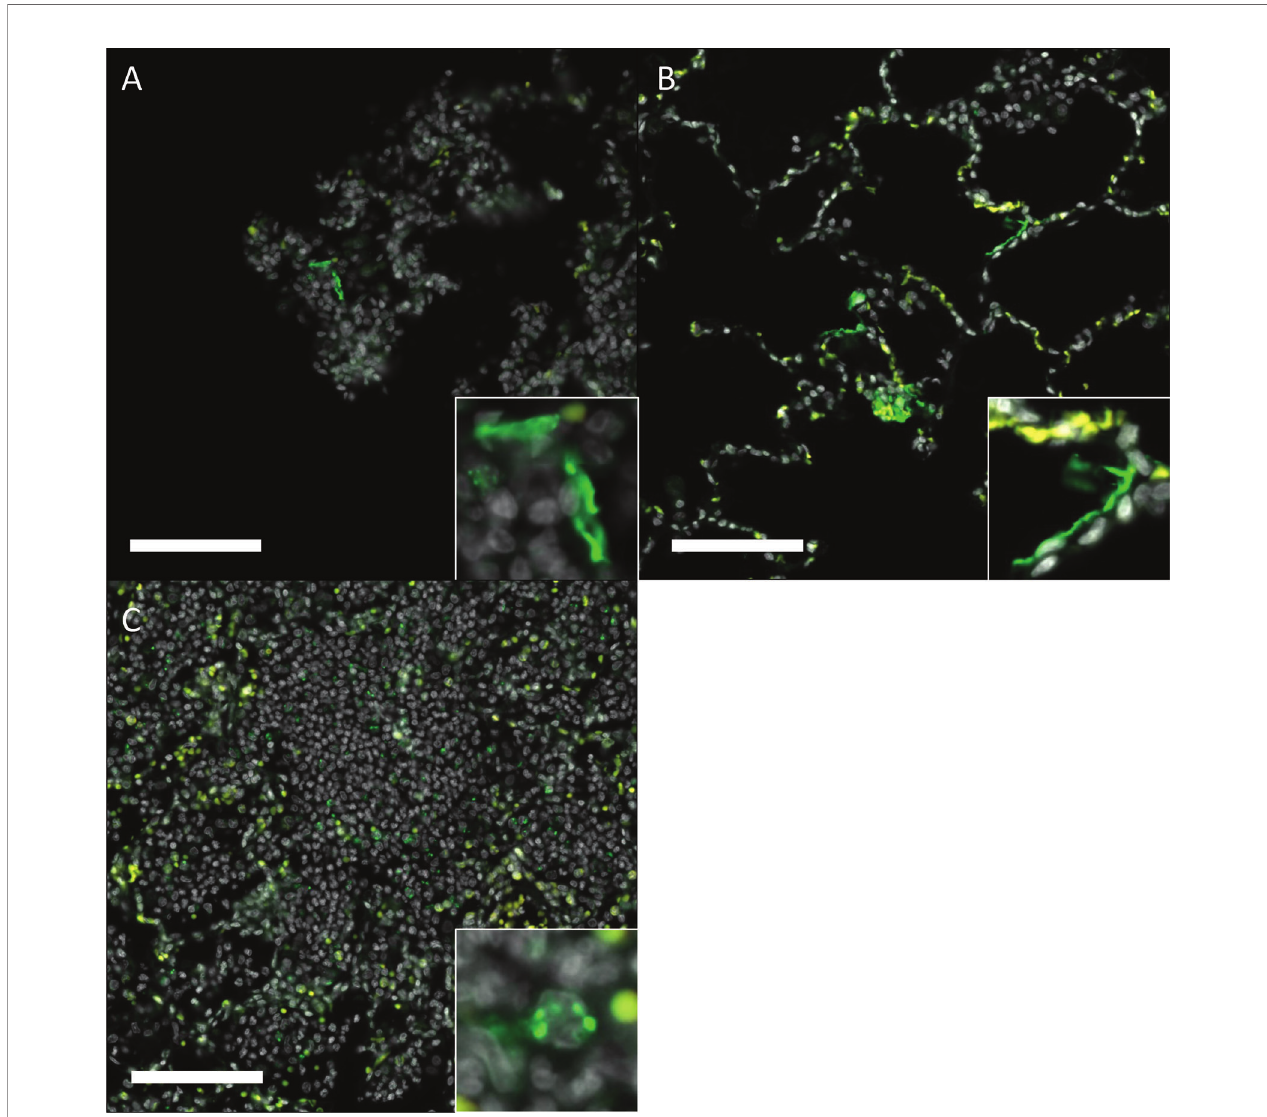
FIGURE 8 | Immuno fl uorescence staining for SARS-CoV-2 in rhesus macaques following prophylactictreatment with combination mAb therapy. (A) Naïve (LM30). Rare SARS-CoV-2 positive cells (green) are present lining alveolar septa. (B) mAb control (IK92). SARS-CoV-2 positive cells are scattered throughout the lungs, often lining alveolar septa. (C) 2 mg/kg (LT54). Within aggregates of in fl ammatory cells, there is scattered, punctate staining within in fl ammatory cells. Insets show a higher magni fi cation of the SARS- CoV-2 positive signal described. DAPI = white, SARS-CoV-2 = green, Red = empty/auto fl uorescence. Bar =100 m